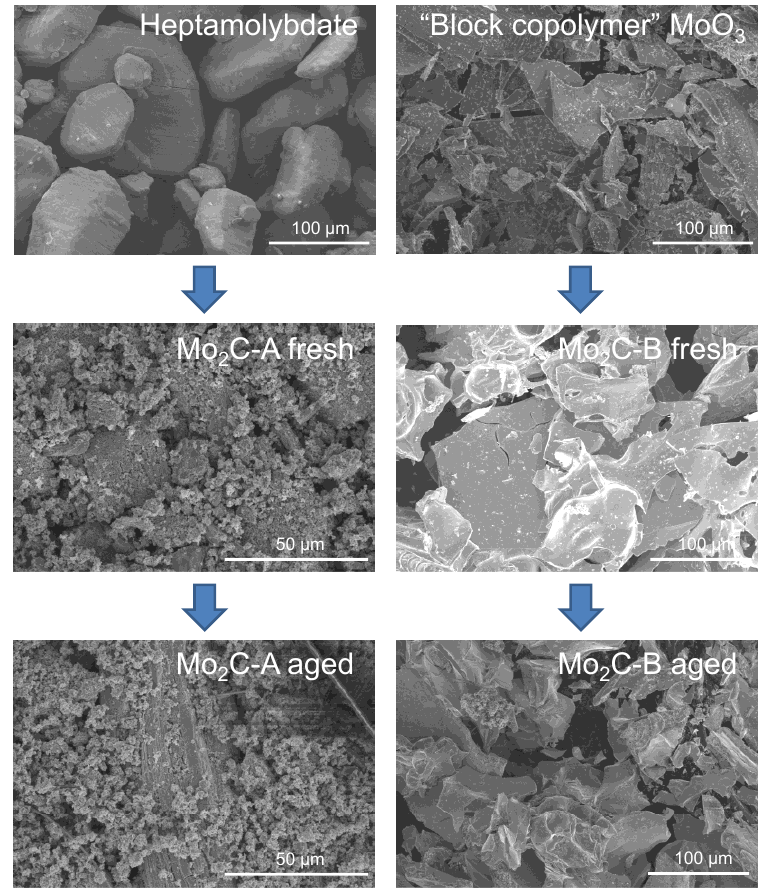
Figure 2. SEM images of the two Mo oxide precursors and resulting carbide samples before and after 48 h aging at 250 °C in liquid water.